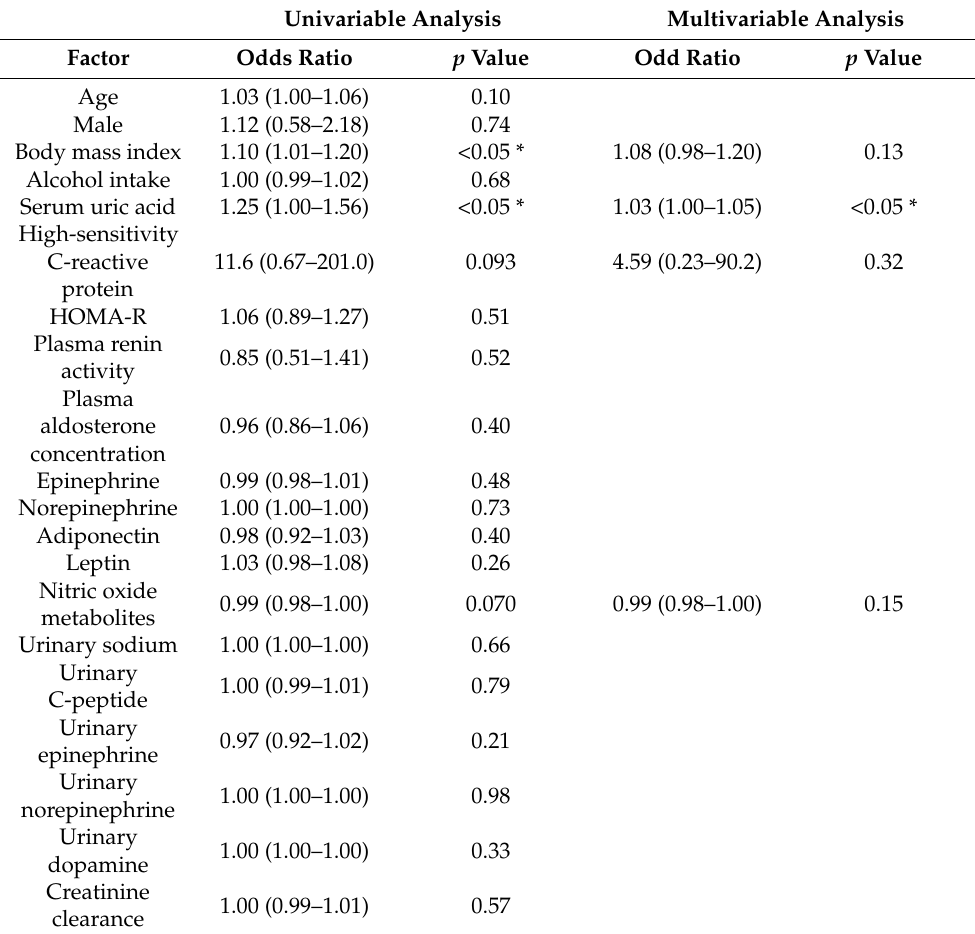
Table 2. Factors associating with non-dipper status. Univariable